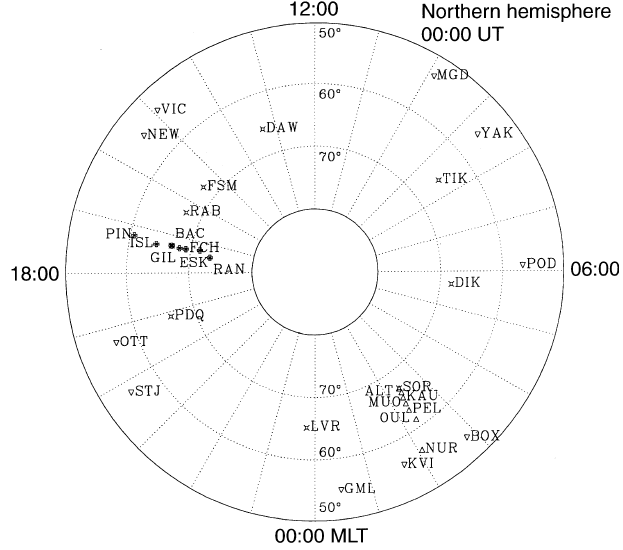
Fig. 1. Polar map illustrating the location, in magnetic local time and IGRF geomagnetic latitude, at 0000 UT, epoch 1990.25 and altitude 0 m, of ground magnetometer stations employed in this study comprising a chain of stations at 55 (cid:176) N ( (cid:44) ), 67 (cid:176) N ( (cid:2) ) and at local times of (cid:126) 0230 MLT ( (cid:110) ) and 1730 MLT ( (cid:68) ) (more stations were used in the AMIE study). In this paper an H , D and Z co-ordinate system is adopted for ground magnetometer measurements. The H compo- nent is tangential to the Earth’s surface and directed toward geomagnetic north, the D component is perpendicular to the average magnetic field and directed toward magnetic east and the Z component is vertically downward. Each component was measured